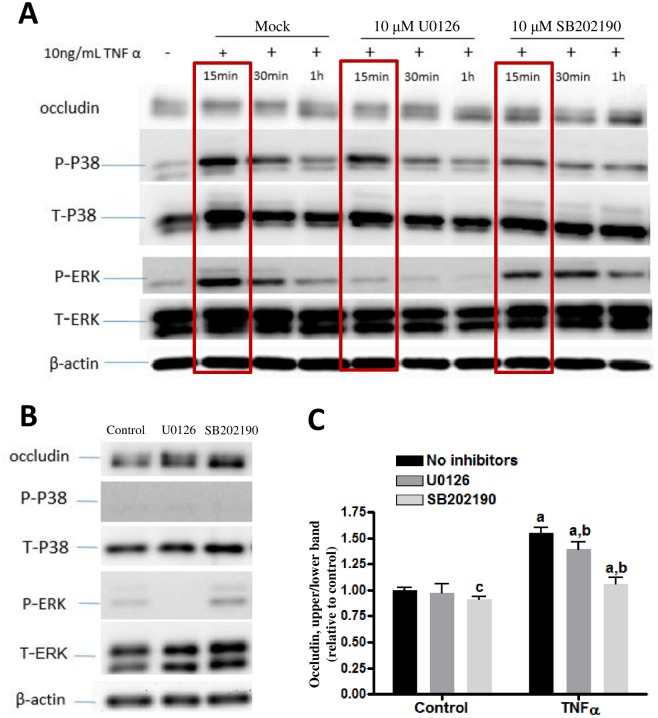
Effects of p-ERK1/2 and p-p38MAPK inhibitors on occludin band-shift in CMEC/D3 cells.Cells were pretreated with or without 10 μM U0126 and 10 μM SB202190 for 15 min and then stimulated with or without 10 ng/mL TNFα for 15, 30, 60 min (A and C). (B) Testing the effects of inhibitors alone. Cell lysates were collected and occludin, P- ERK, T-ERK, P-p38, T-p38 and β-actin expression pattern was analyzed by immunoblotting assay. Quantification of the proportions of occludin upper band at 15 min of TNFα and with inhibitors (blots enclosed in brackets) were determined through PIupper /PItotal/PIβ-actin and then normalized to control. Results are mean ± SD from 4 or more experiments. Two-way ANOVA revealed significant main effects of TNFα and the inhibitors and a significant interaction (p<0.0001 for each). Bonferroni post-test showed significant differences between TNFα-treated groups as compared to their respective controls (as indicated by the letter “a”), SB202190 alone as compared to control/no inhibitors (as indicated by the letter “c”) and TNFα-treated groups with vs. without the inhibitors (as indicated by the letter “b”).